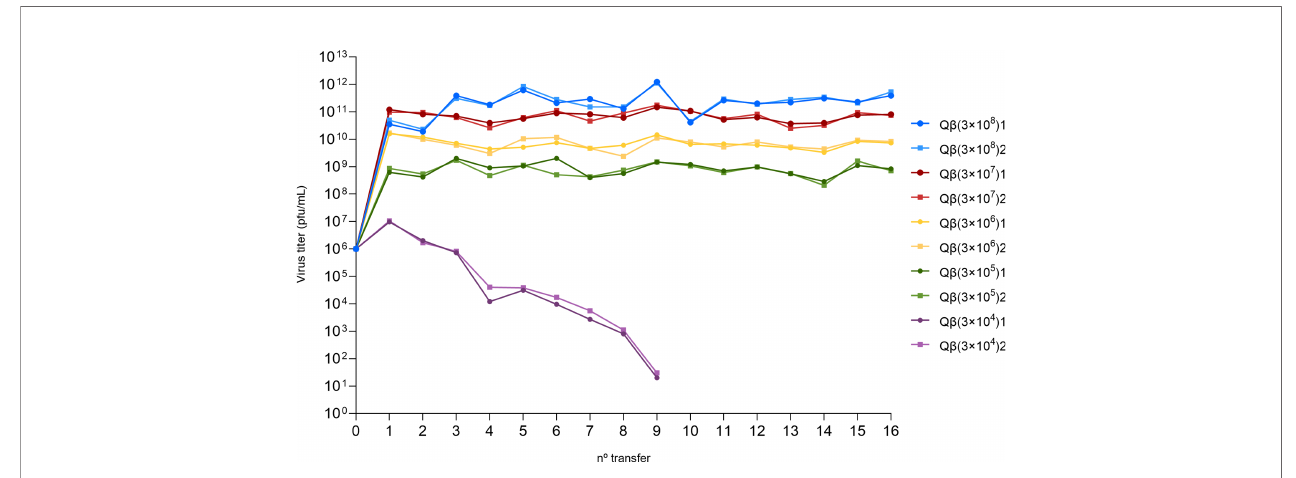
FIGURE 2 | Virus titers obtained at each transfer of the evolution experiment ( Figure 1 ). The color code used to distinguish the lineages evolved at different host density is the same shown in Figure 1 . In each case, lineage 1 is represented with circles and lineage 2 with